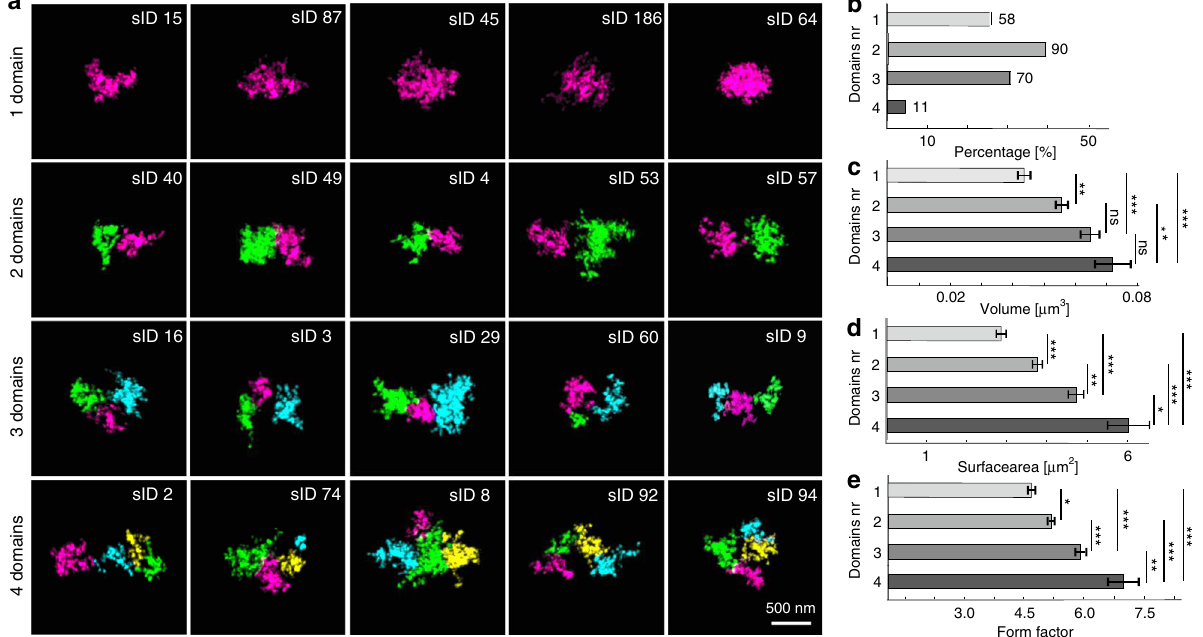
Fig. 4 3D-EMISH statistical analysis of chromatin-folding domains. a Classi fi ed 1, 2, 3, 4 distinctive chromatin-folding domains examples. Identi fi ed chromatin-folding domains in each 3D image were presented by different colors (magenta, green, cyan, and yellow for fi rst, second, third, and fourth domain group, respectively); scale bar, 500 nm. b 3D-EMISH chromatin-folding domain histogram of 229 structures: one domain (58/229, 25%), two domains (90/229, 39%), three domains (70/229, 31%), four domains (11/229, 5%). Volume ( c ), surface area ( d ), and form factor ( e ) statistics for all 229 images for four distinctive classi fi ed chromatin-folding domains. This experiment was repeated independently two times with similar results. Error bars indicate SEM. Kruskal – Wallis test, and two-sided Mann – Whitney tests with Bonferroni correction were performed; ns (statistically insigni fi cant); statistically signi fi cant differences: * p ≤ 0.05; ** p ≤ 0.01; *** p ≤ 0.001. P -values [volume] (1~2: 0.007; 1~3: 0.000; 1~4: 0.000; 2~3: 0.166; 2~4: 0.009; 3~4: 0.261); [surface area] (1~2: 0.000; 1~3: 0.000; 1~4: 0.000; 2~3: 0.002; 2~4: 0.000; 3~4: 0.016); [form factor] (1~2: 0.025; 1~3: 0.000; 1~4: 0.000;